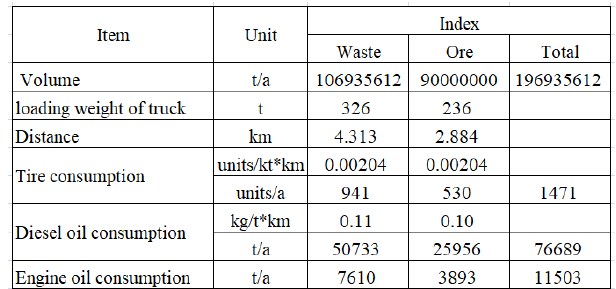
10 of 12 Figure 5. Software management interface.